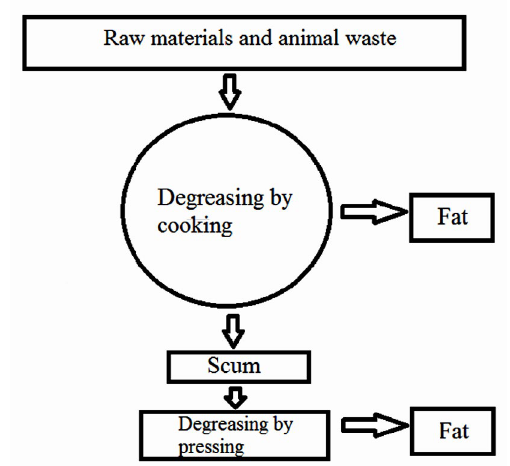
Fig. 2. Technology for degreasing raw materials and animal waste